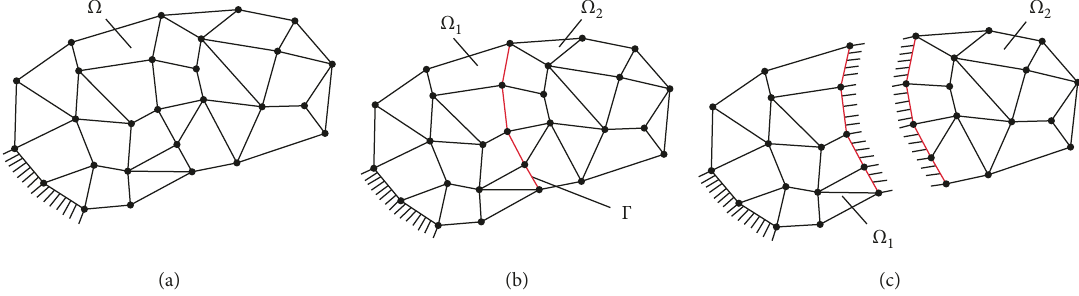
Figure 5: Global and partitioned structural models and interface handling in the Craig–Bampton method. (a) Global (nonpartitioned) structure Ω ; (b) substructures Ω i ( i � 1, 2, ... , S) and interface boundary Γ ; (c) interface boundary